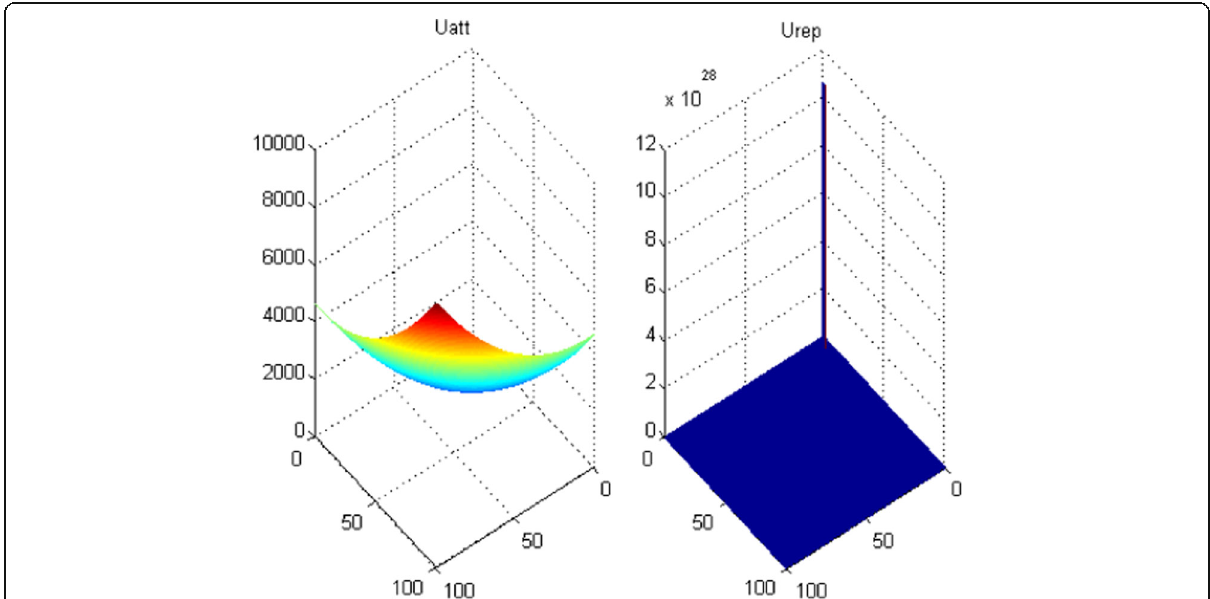
Fig. 25 Mesh plot of the potential energy of attraction and repulsion in the modified artificial potential field algorithm for the straight line obstacle